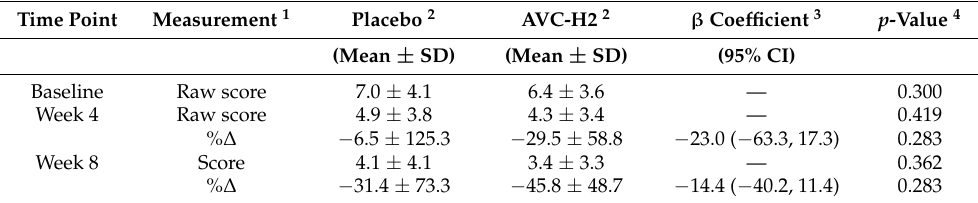
Table 3. WOMAC sub-score in the pain domain from the baseline to the follow-up